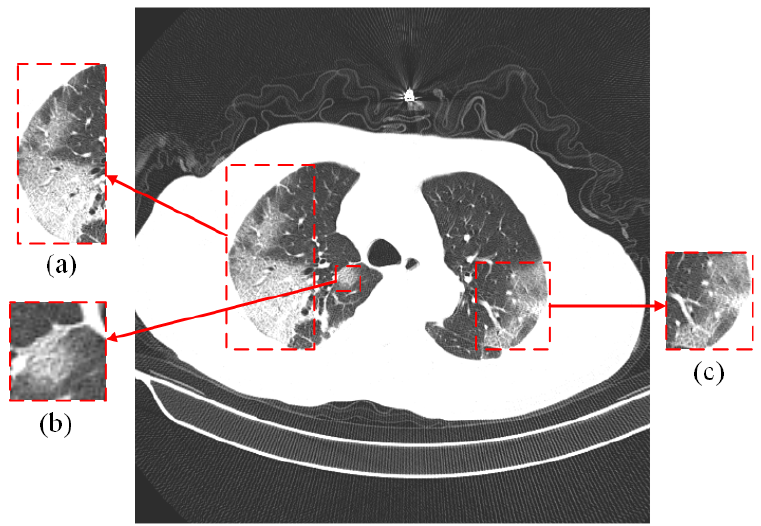
Figure 1. The lung CT image of a COVID-19 patient. ( a – c ) are ground glass images. The original image comes from the COVIDx CT-2A dataset